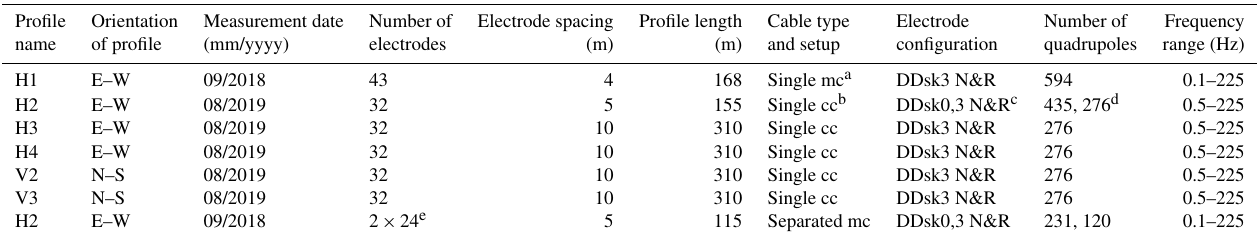
Figure 1. (a) The Lapires study site located in the western Swiss Alps, with information about the assumed spatial extent of the permafrost body according to Delaloye (2004), Lambiel (2006) and Scapozza et al. (2015). SIP data were collected along six profiles: H1 denotes the PERMOS long-term ERT monitoring profile, and H2 denotes the cable test profile (see paper for further details). (b) The borehole temperature data of BH-1108, BH-0198 and BH-1208 taken on the day of SIP measurements in August 2019. Note that BH-1308 did not show permafrost during drilling (temperatures not shown). (c, d) Photographs of the talus slope, surface characteristics and the deployed coaxial cables. Table 1. Overview of the SIP measurement setup deployed along seven profiles to evaluate the data quality for different cable types and setups and for mapping